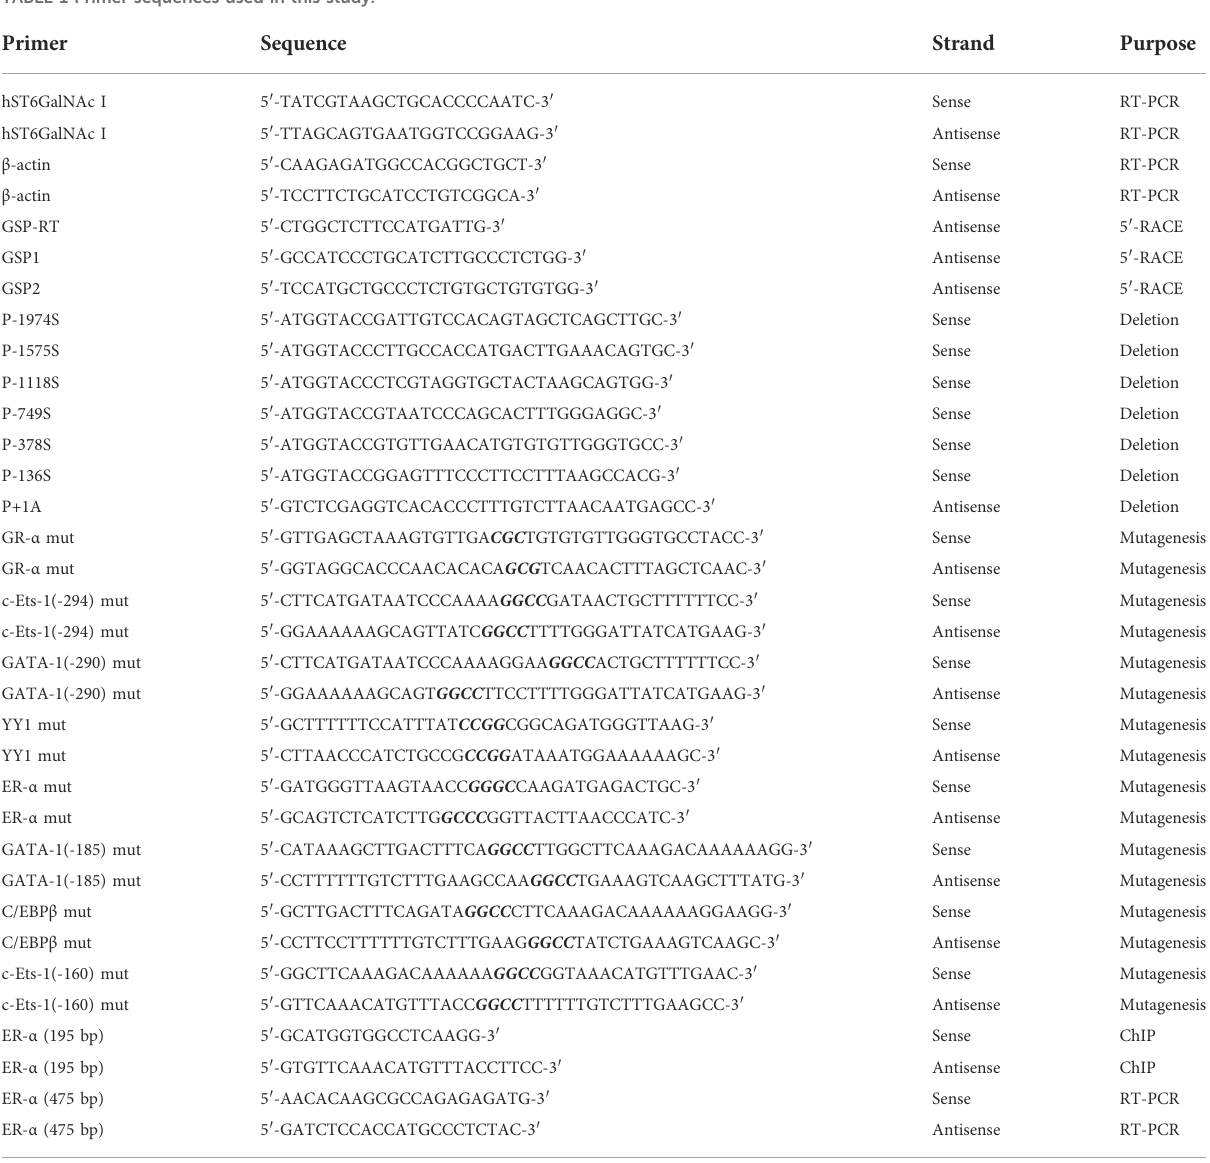
TABLE 1 Primer sequences used in this study. Primer